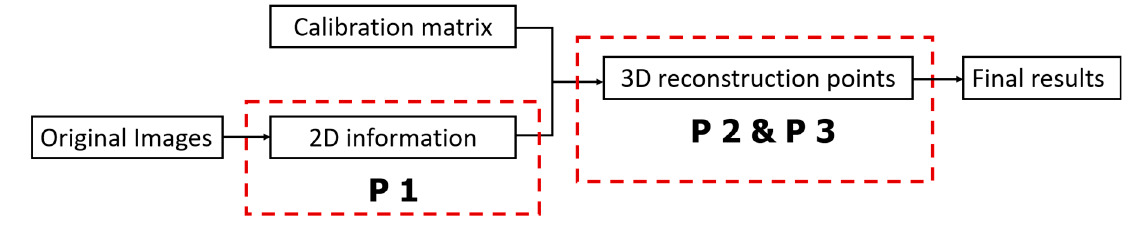
Figure 4. Proposal 1 introduced in 3.1 is applied at the 2D level. Proposal 2 in 3.2 and proposal 3 in 3.3 are applied at the 3D level.